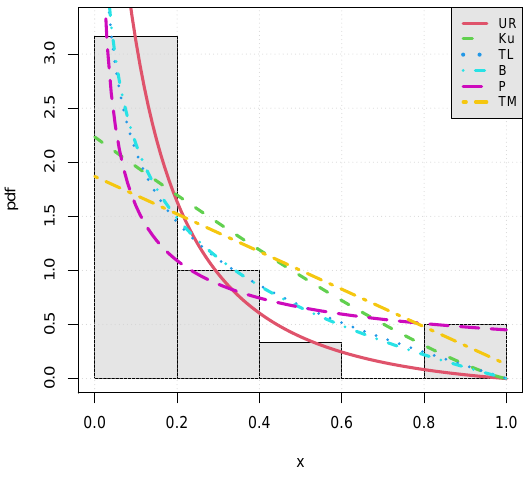
Figure 9. Plots of the estimated pdfs of the considered models for the failure times data